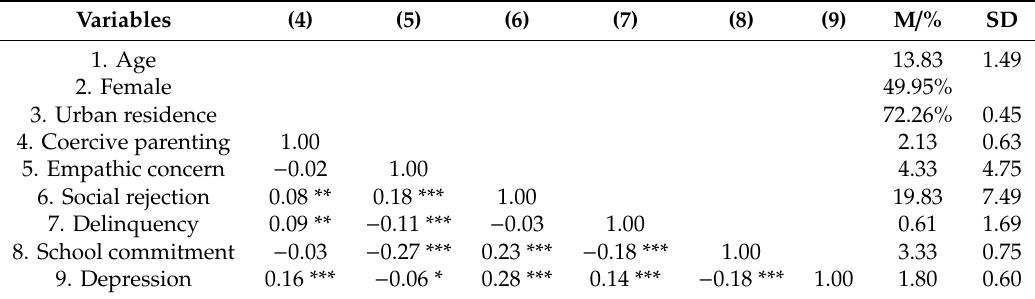
Table 1. Descriptive statistics and bivariate correlations of study variables ( N = 1085).